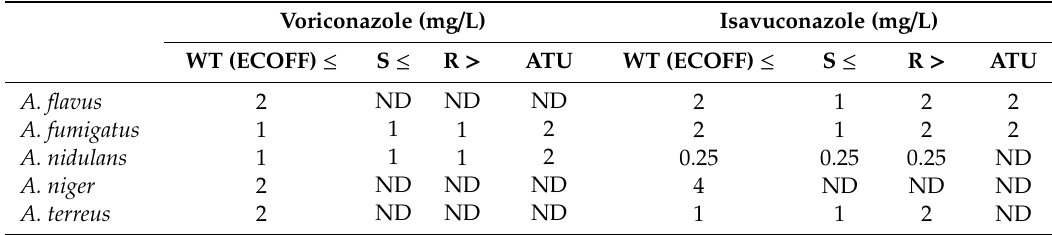
according to the EUCAST breakpoint table v 10.0, 2020 [33].